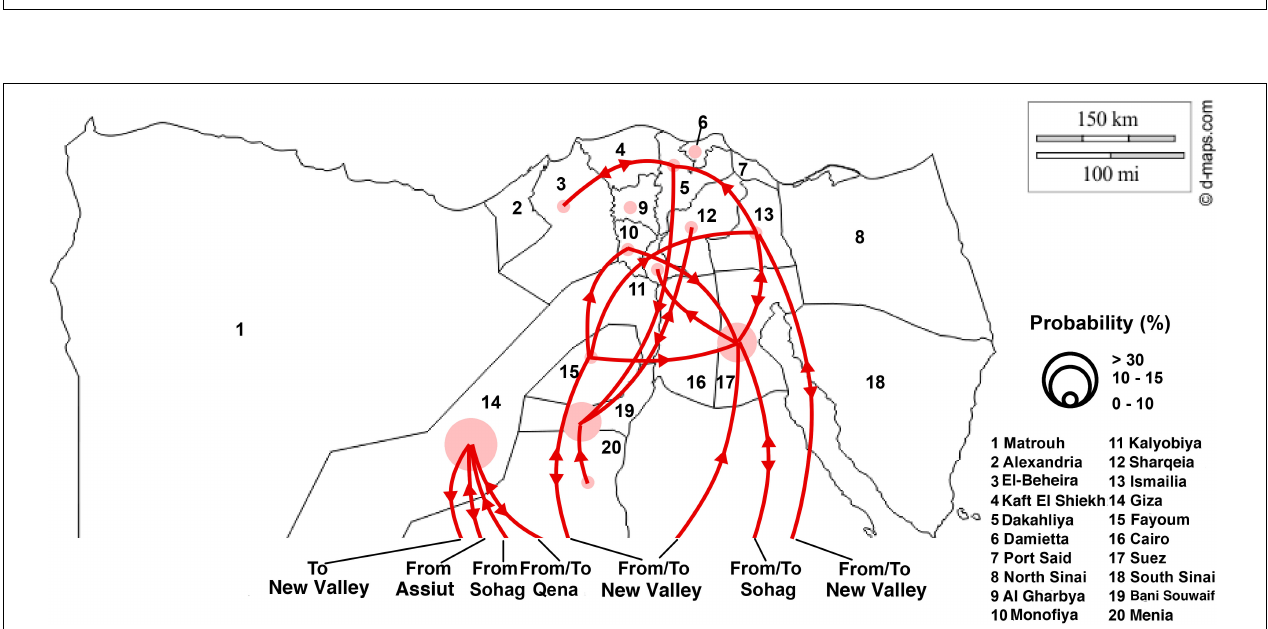
FIGURE 4 | Migration pathways of LPAI H9N2 viruses in Egypt. Lines with arrows illustrate main migration routes between the different governorates (1–20). The size of the circle indicates relative chance of a governorate acting as a migration source.